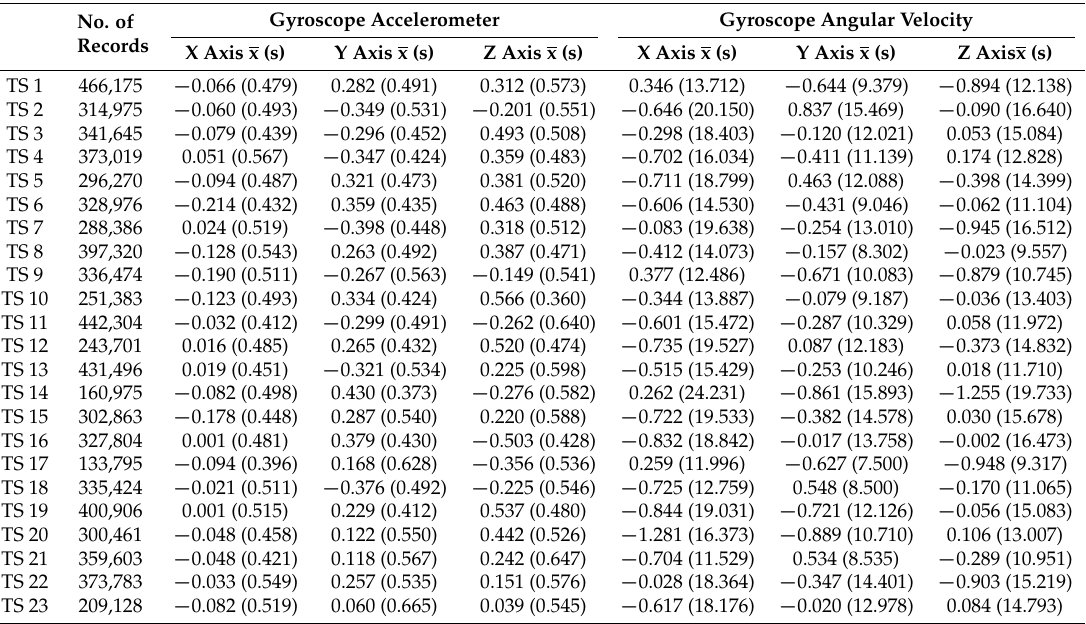
Table A1. Normal conditions dataset. Part I.